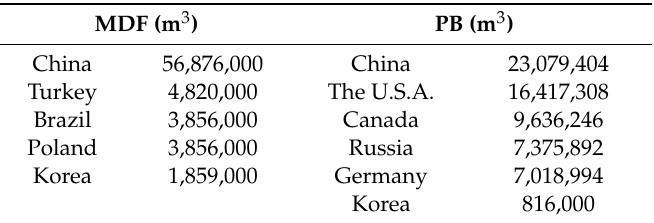
Table 1. Summary of world production information of particle board (PB) and medium-density fibreboard (MDF) in